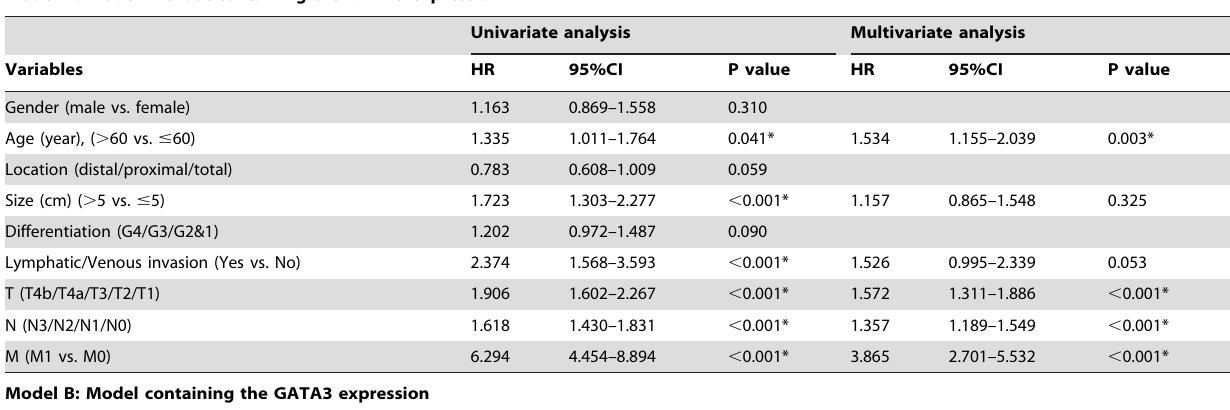
Model A: Model without containing the GATA3 expression Univariate analysis Multivariate